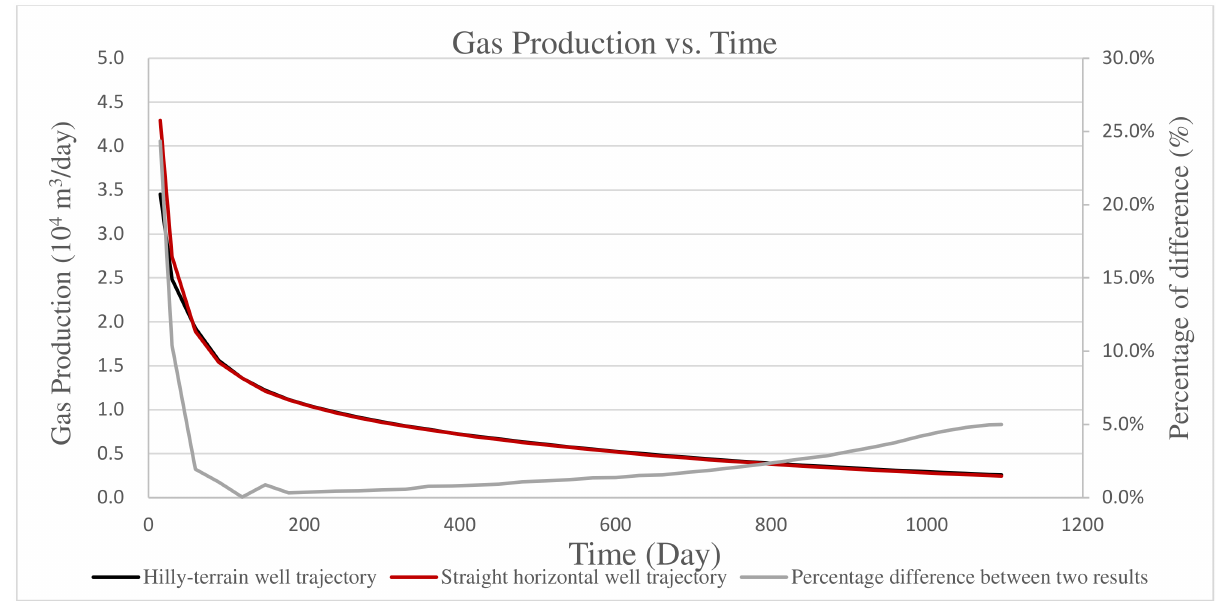
Figure 9. Comparison between the hilly-terrain well trajectory case and the perfectly straight well trajectory, and the percentage difference between the two results plotted on the secondary y